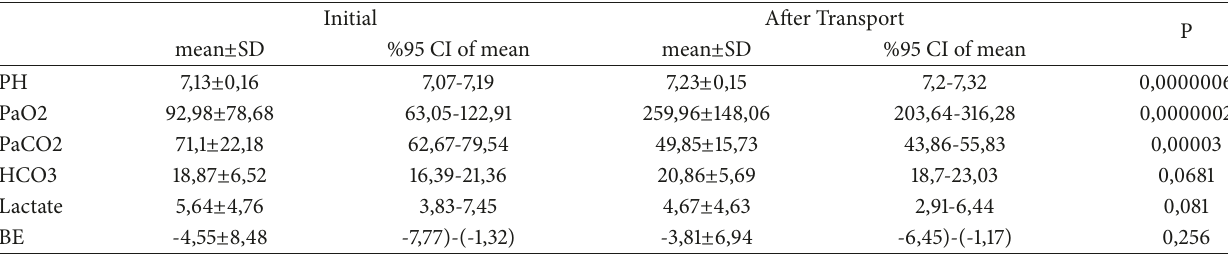
Table 4: Blood gas analysis of type 2 respiratory failure patients.